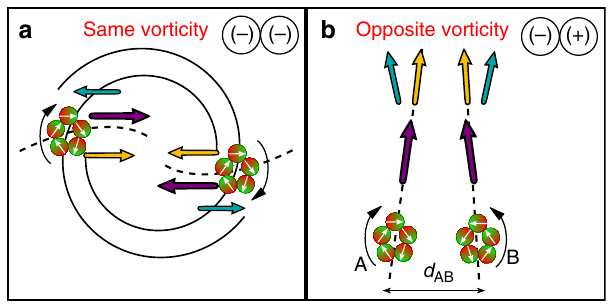
Figure 8 | Schematic trajectories for two rotating ring-like clusters. ( a ) Two ring-like clusters A, B of N ¼ 5 swimmers each, rotating with same vorticity and an initial distance will approach while propagating on a spiral, while pushers may repel each other. Dashed lines show the trajectories of the individual centers of velocity for neutral swimmers. The coloured arrows indicate the direction of the acting forces due to hydrodynamic interactions, as in Fig. 3. ( b ) For rings rotating with opposite vorticity, the clusters will approach each other for all microswimmer types. Their respective centers of velocity move on straight lines. For pushers it is possible that the rings move apart from each other at larger velocities.